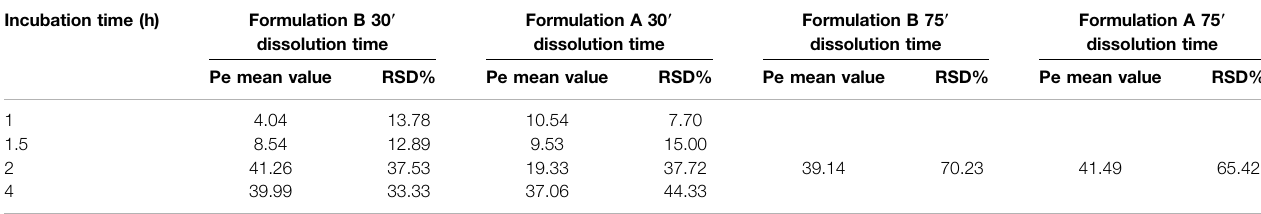
TABLE 1 | Mean values and RSD% of the LVN Pe. The results were obtained by applying the equation reported in PAMPA test validation paragraph taking into account the different incubation times. The results refer to both the experiments carried out after 30 ′ and 75 ′ dissolution time. The reported values are the mean of four independent